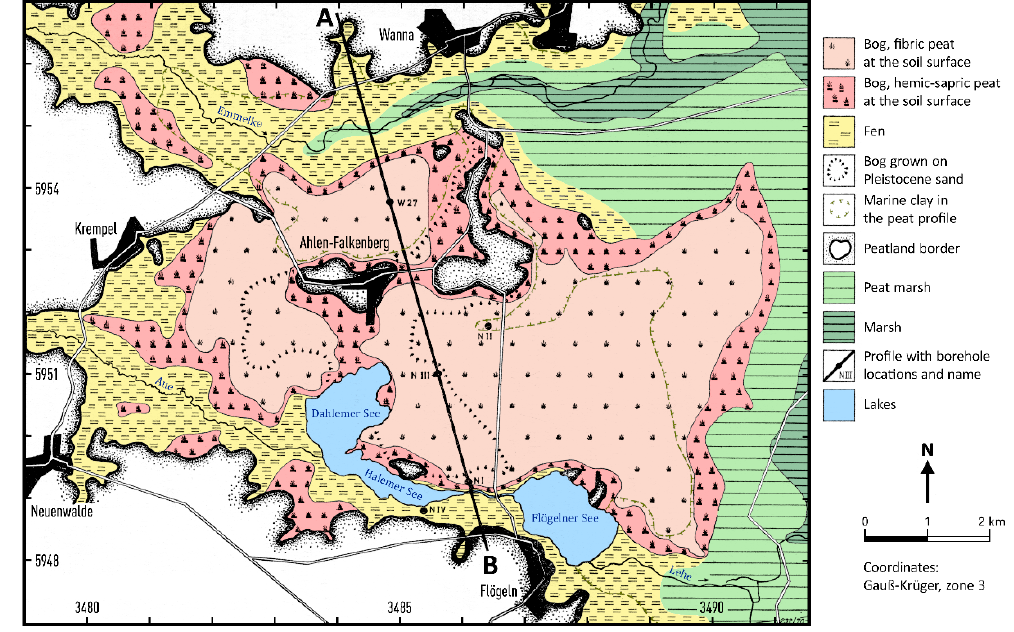
Figure 2. Quaternary geology map of the study area (after [15], colors and legend changed).